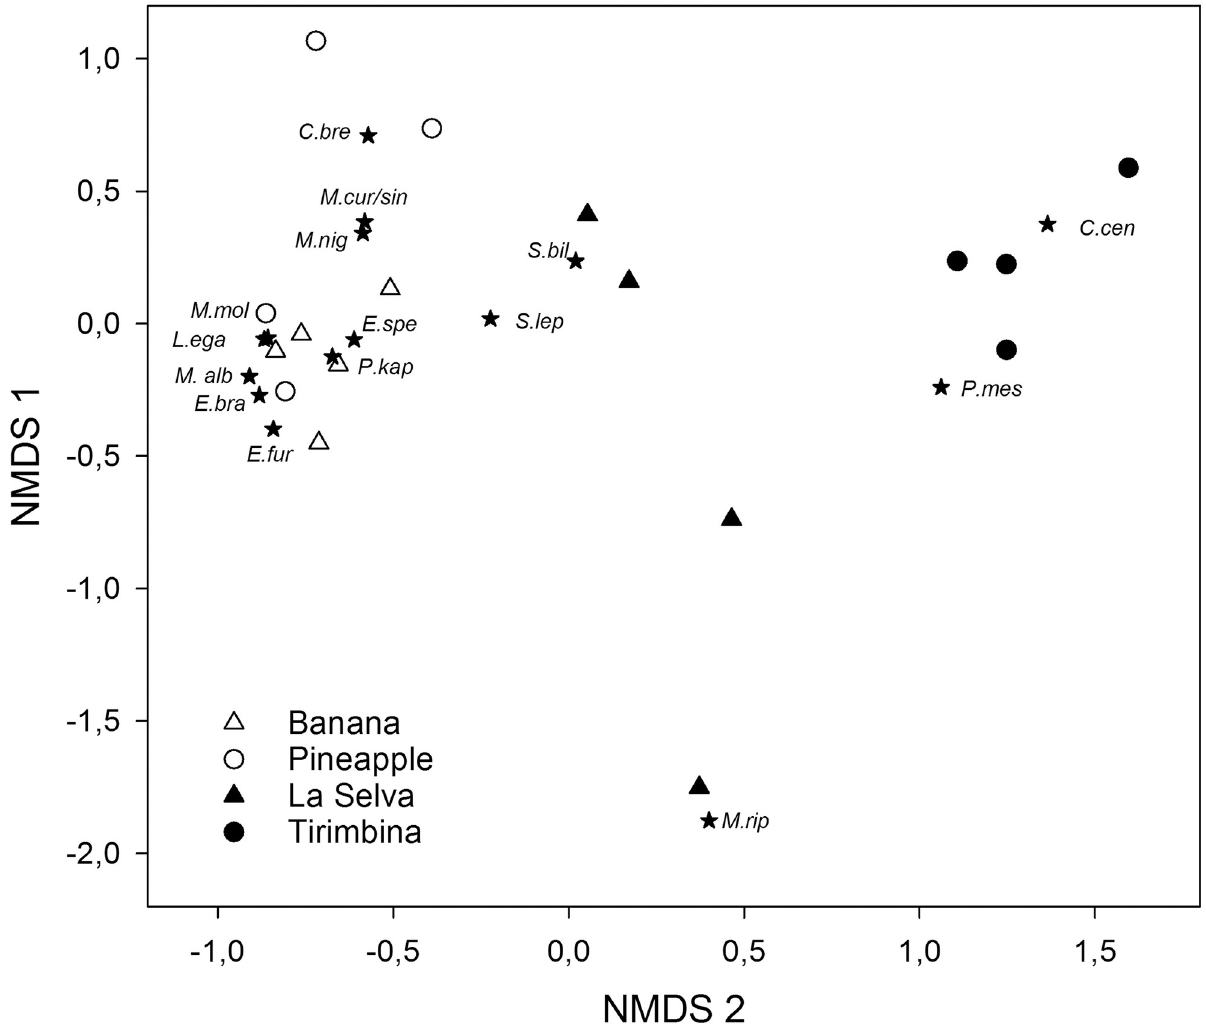
Fig 5. NMDS of recording sites. Non-metric multidimensional scaling of recording sites based on Bray-Curtis dissimilarities species composition of aerial insectivorous bats weighted by their mean activity at each recording site in Sarapiquı´, Costa Rica.